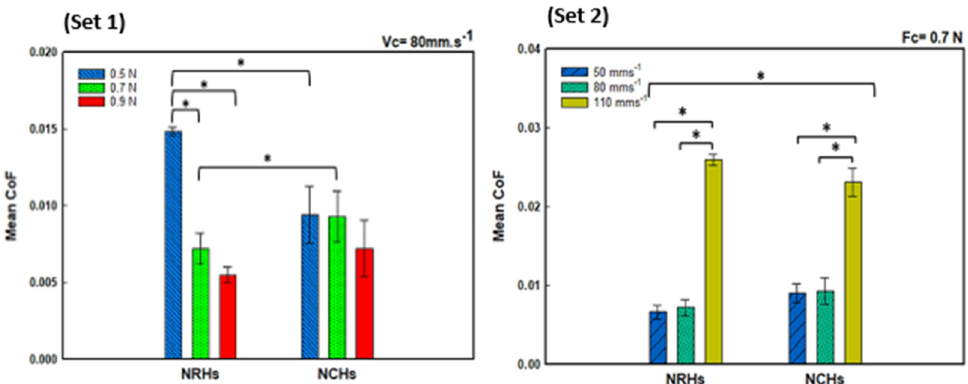
Figure 3. Mean values of the coefficient of friction for NRHs and NCHs samples in lubricated condi- tion versus (set 1) applied load (Vc = 80 mm/s), and (set 2) sliding speed (Fc = 0.7 N), (n = 3 ± SD). * ANOVA and post-hoc Tukey tests ( p < 0.05) were conducted for statistical significance analyses.